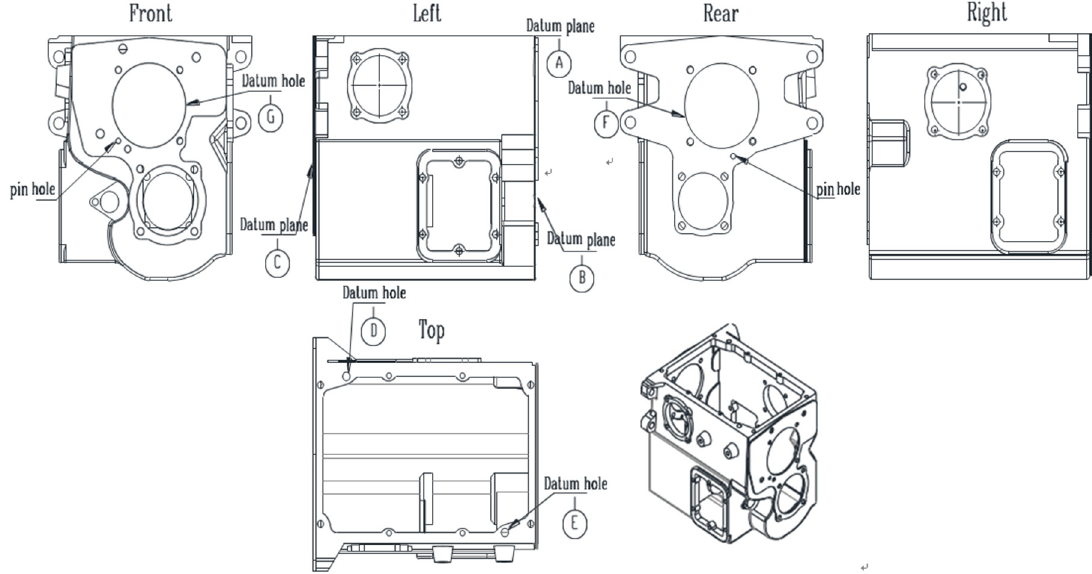
Figure 6. Drawings of the box key evaluation benchmark from three views.